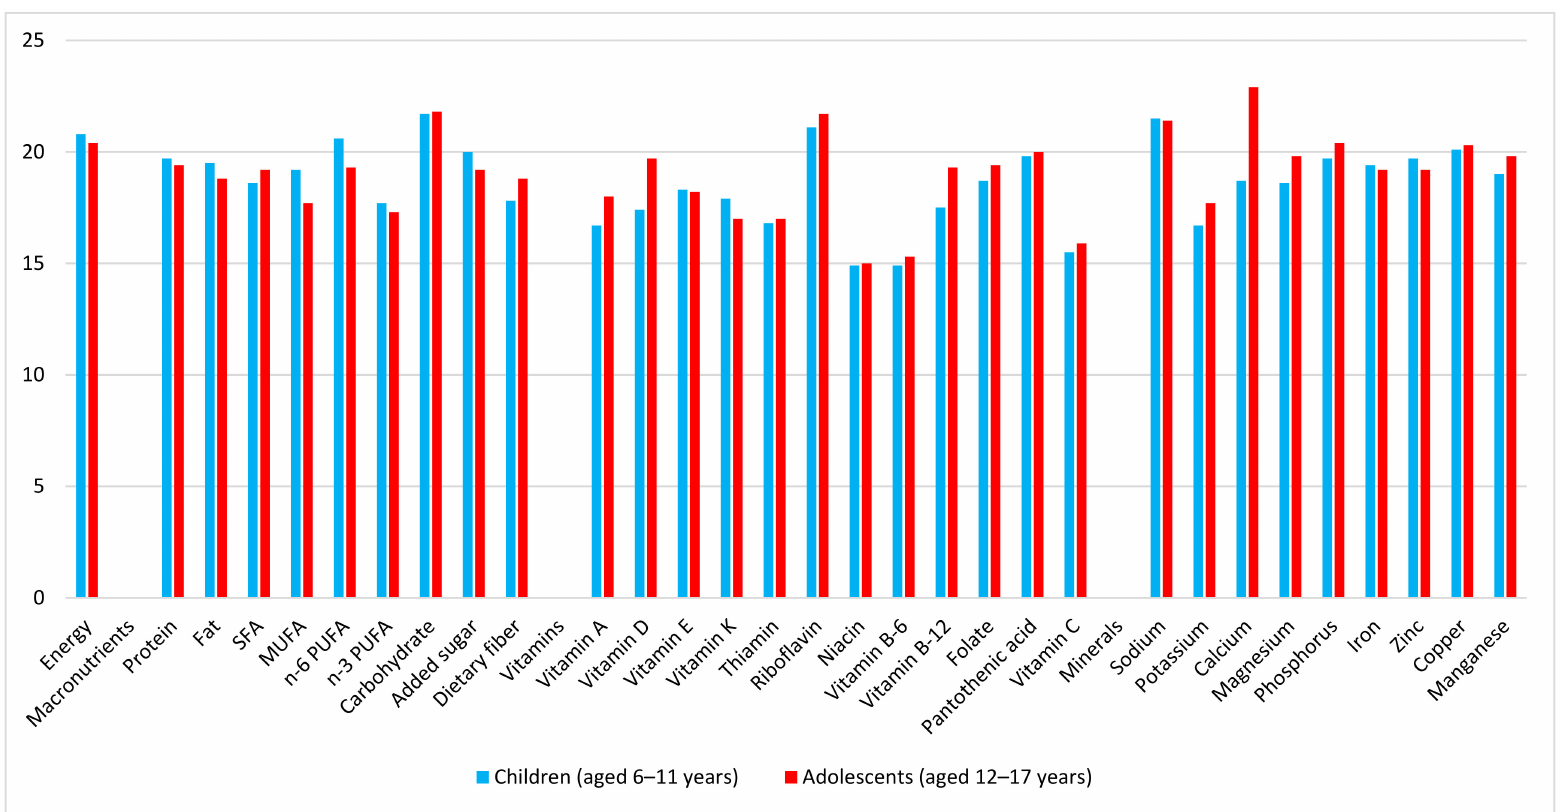
Figure 1. Percentage contribution of breakfast to daily intakes of energy, macronutrients, vitamins, and minerals in children (aged 6–11 years; n = 1434) and adolescents (aged 12–17 years; n = 1104). Values are